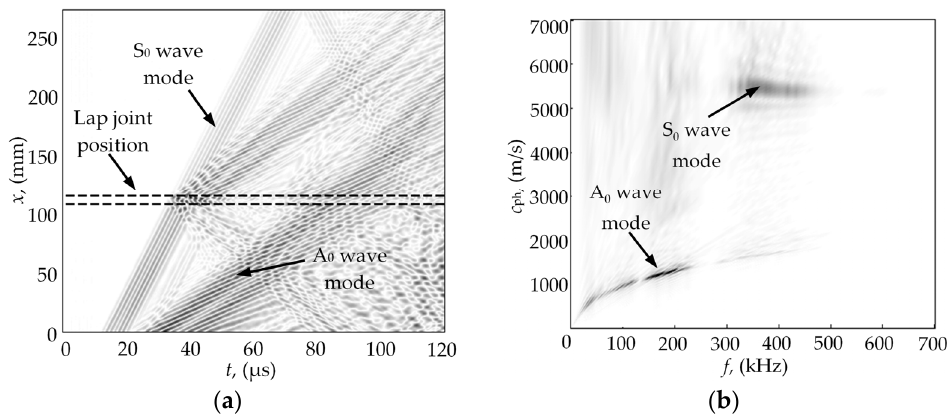
Figure 11. ( a ) An experimentally obtained B ‐ scan image of the ultrasonic guided waves propagating through the lap joint welded plates in the case of the 4 mm overlap zone width; ( b ) reconstructed guided waves dispersion curve pattern by using 2D Fourier transform (FT).